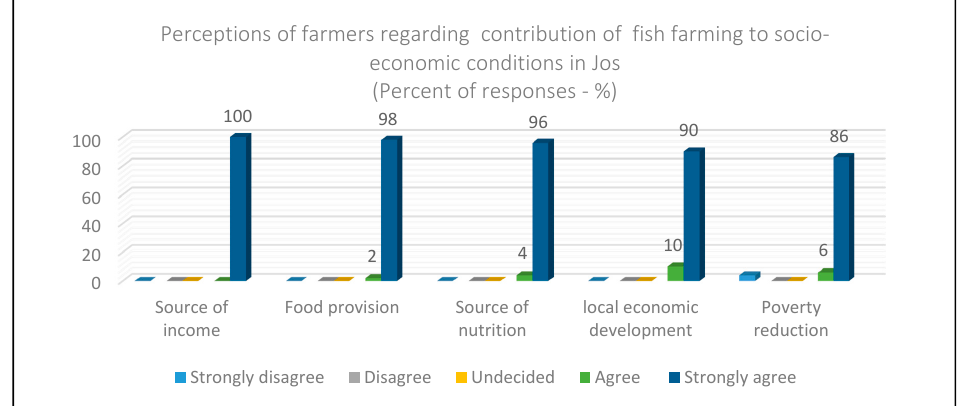
Figure 5. Farmers’ perceptions concerning the contribution of urban fish farming in Jos towards improving economic and social conditions.